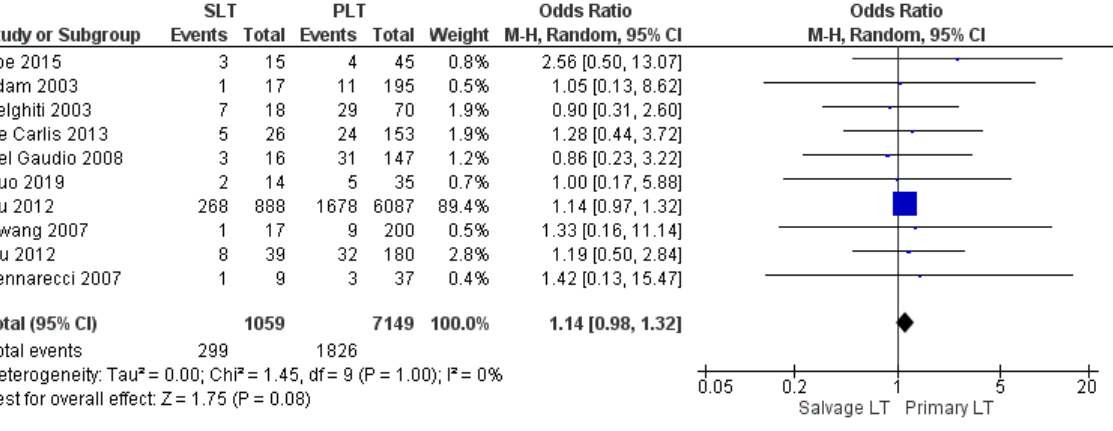
Figure 15. Infection and sepsis.